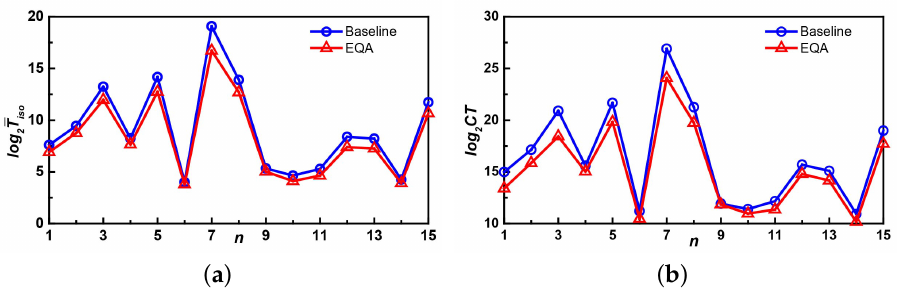
Figure 11. Comparison results on the YEAST dataset. ( a ) The comparison of T iso ; ( b ) the comparison of CT . EQA, Efficient Query Answering.